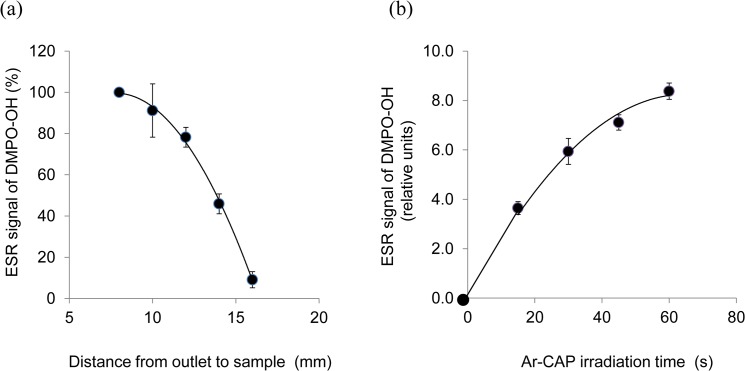
Effect of distance and exposure time on ·OH formation.(a) DMPO-OH adducts signal intensity decreases with increasing the distance from the plasma tube nozzle to sample. The yields at different distances are given as percentage from that at 8 mm considered as 100% (b) DMPO-OH adducts signal intensity increases with increasing Ar-CAP irradiation time.